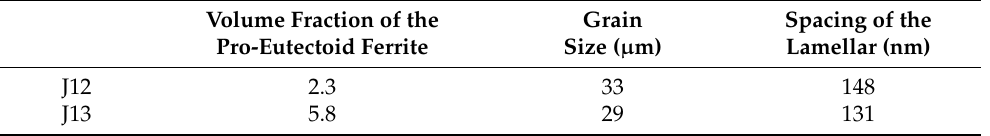
Table 4. The difference in microstructural parameters for the two types of wheel steel.